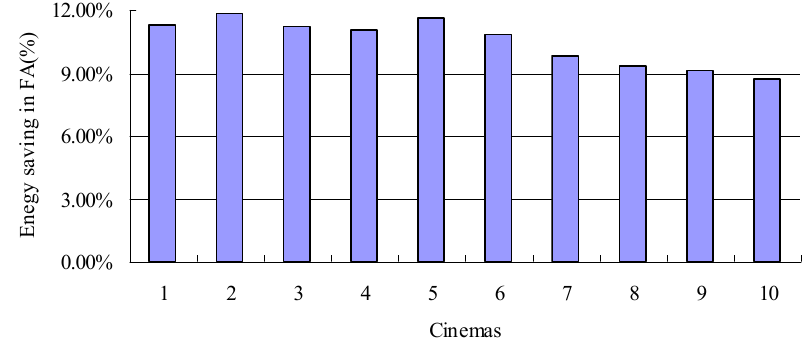
Figure 4. Energy saving percentage in fresh air system.